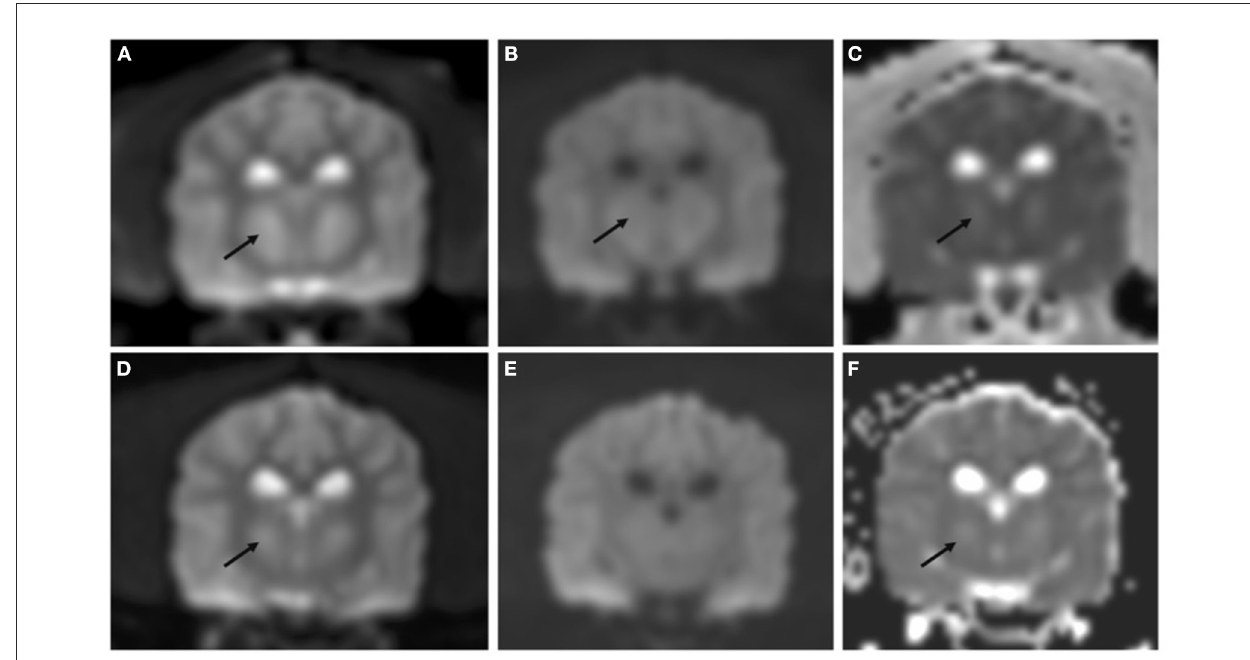
FIGURE3 Transverse DWI and ADC map performed on day 4 of hospitalization (A–C) and at recheck 130 days later (D–F) . Bilateral symmetric hyperintensity on DWI B0 images (A, D) and ADC map (C, F) is most consistent with T2 shine through. DWI B1000 showed mild hypointensity [arrow in (B) ] not present at the follow up MRI (E) , these findings were most consistent with